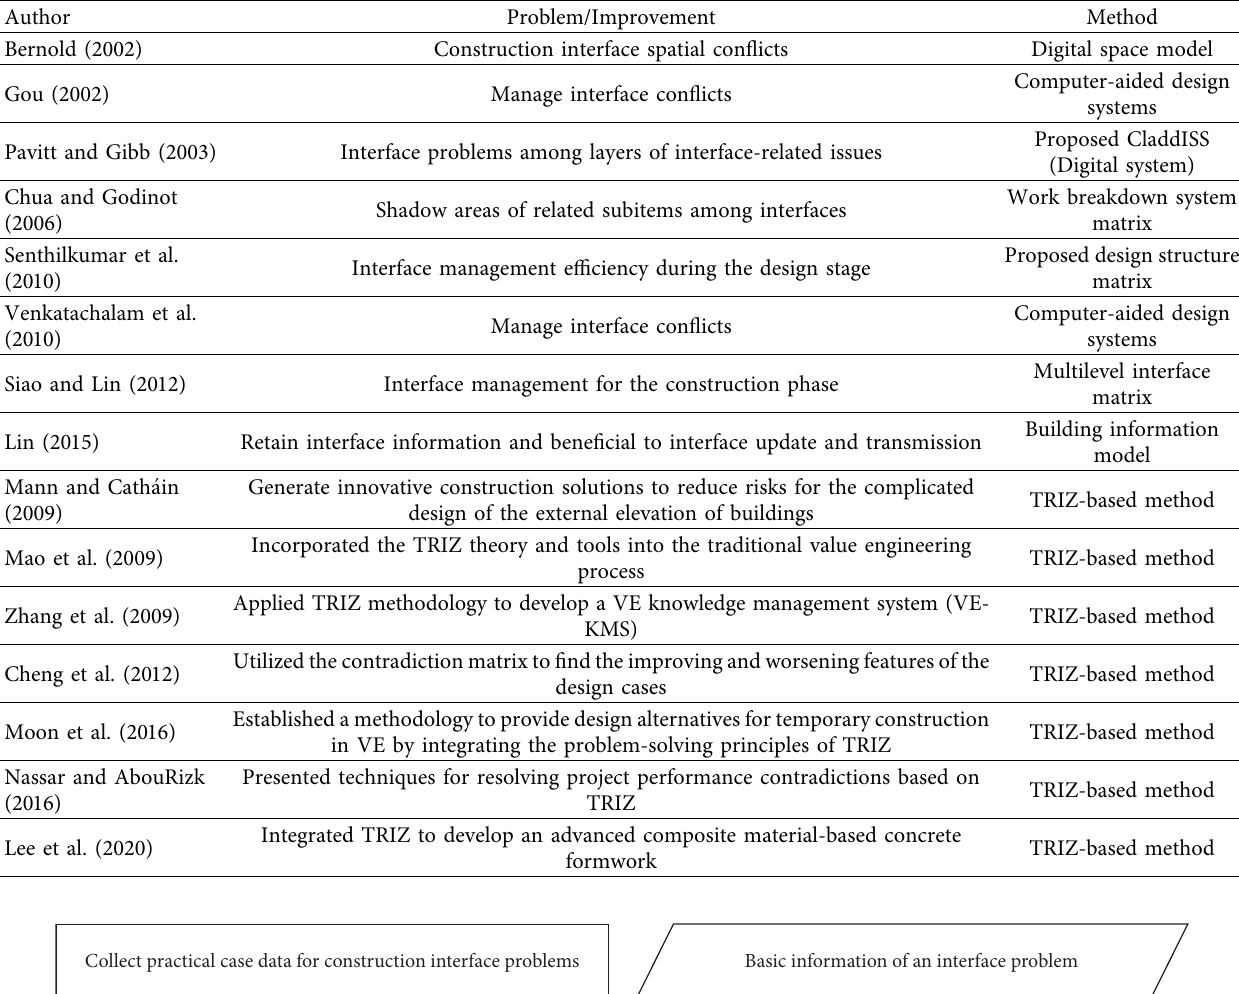
Table 1: Relevant studies on construction interface problems and TRIZ-based problem-solving applications.